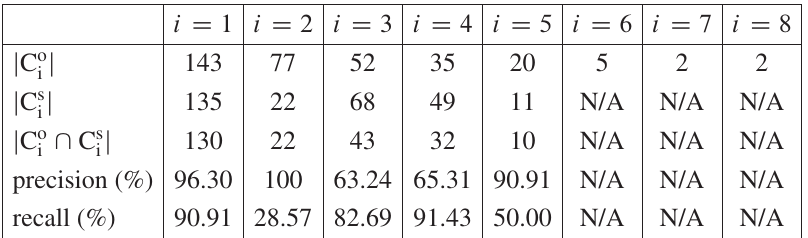
Table 3. Clustering result of shrinking algorithm for Ecoli data.